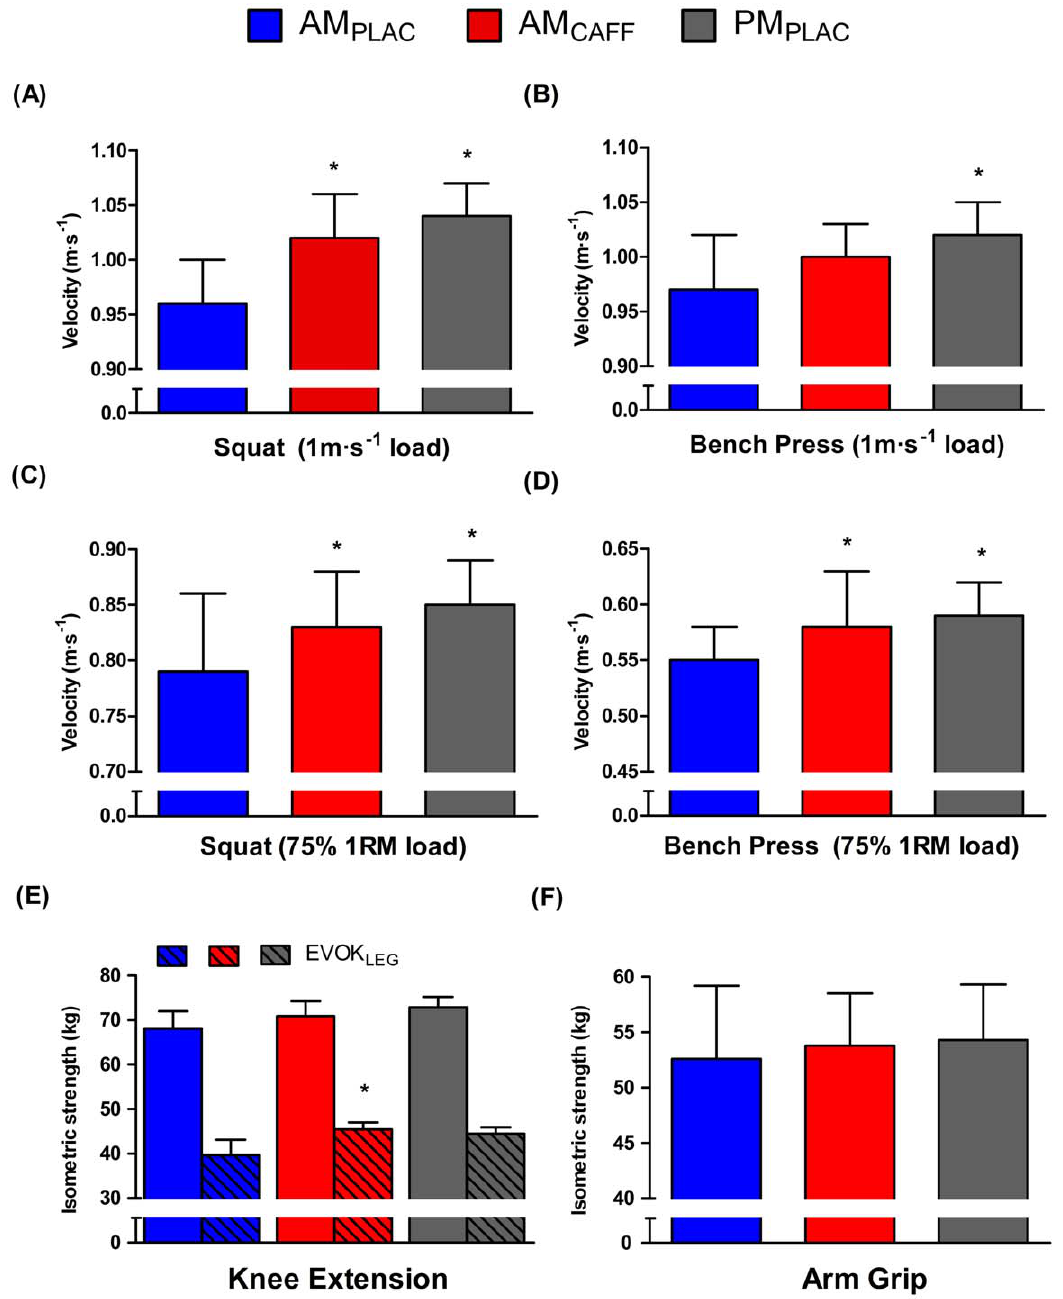
Figure 2. Effects of circadian rhythm pattern and caffeine ingestion on dynamic and isometric maximum strength and muscle power values for upper and lower body actions. A) and B) Velocity for maximal power and; C) and D) Velocity for maximum strength loads for squat and bench press exercises; E) Maximal isometric voluntary contraction strength (MVC LEG ) and electrically evoked strength (EVOK LEG ) on the right knee; F) Maximal isometric grip strength. Trials were conducted in the morning (10:00 am) without (AM PLAC ) or with caffeine ingestion (i.e., 3 mg kg 2 1 ; AM CAFF ) and in the afternoon (18:00 pm; PM PLAC ). Data are means 6 SD. *Significant differences compared to the AM PLAC values. p # 0.05.